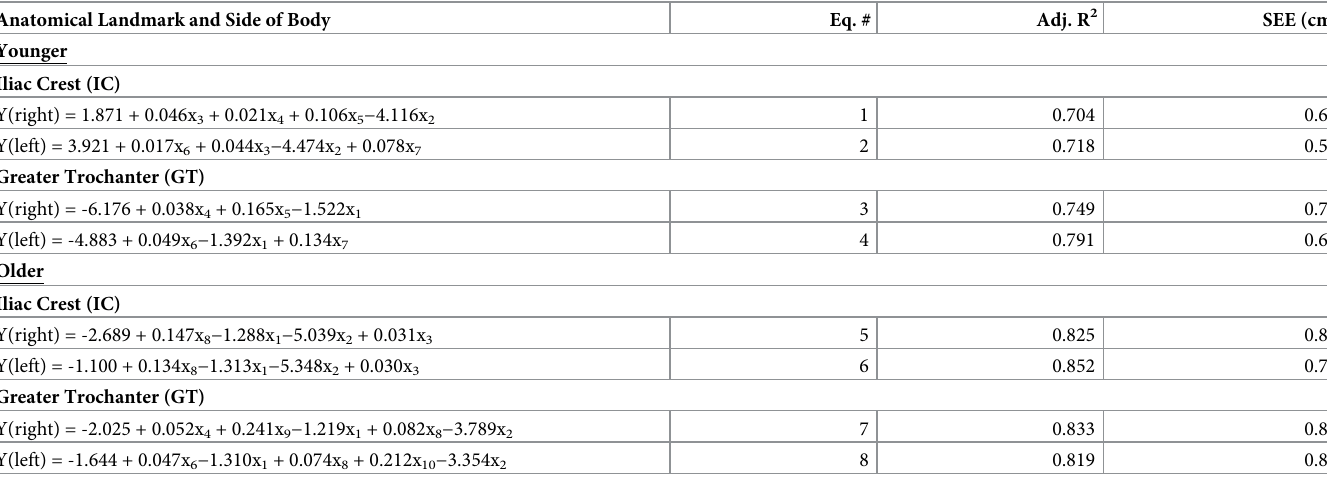
Table 4. Prediction equations for the left and right iliac crest (IC) and greater trochanter (GT) soft tissue thicknesses for the younger and older adult populations. Anatomical Landmark and Side of Body